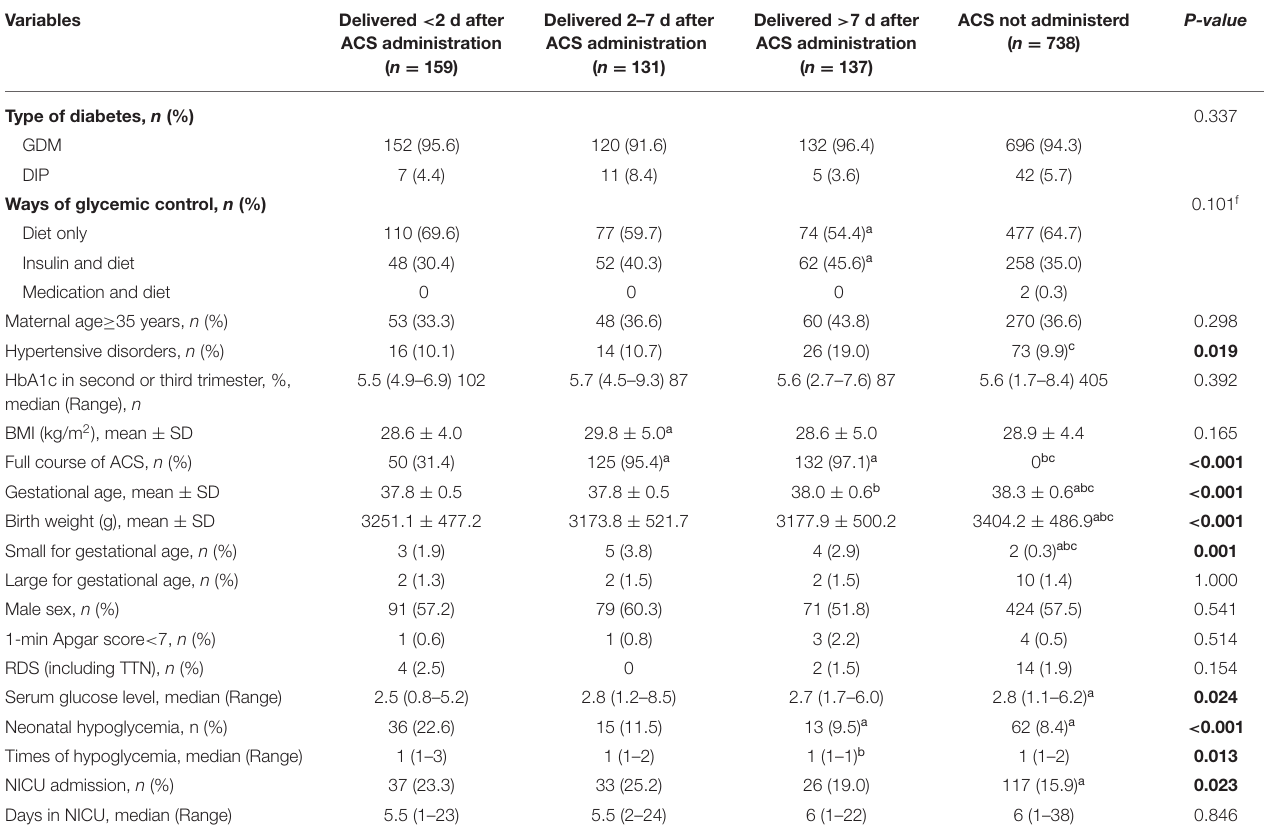
TABLE 1 | Characteristics of the studied groups.